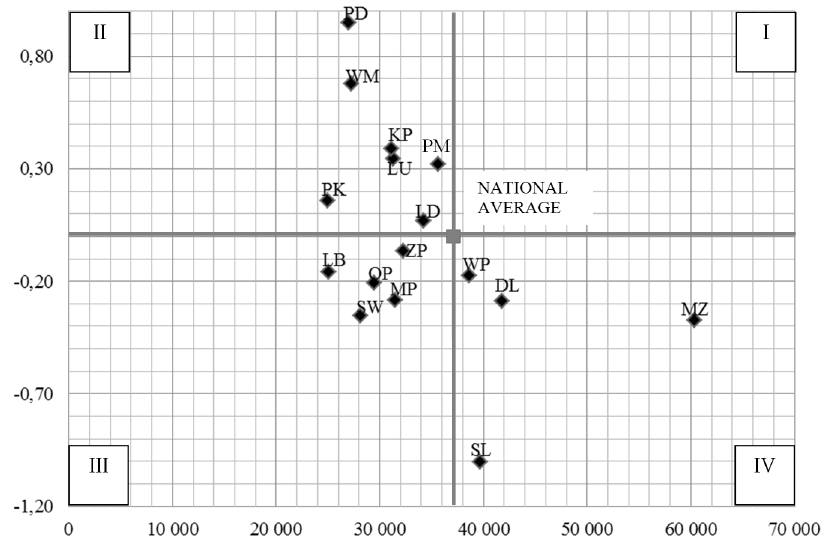
Figure 2. Gross Domestic Product in zloty per capita and the quality of the environment in Polish regions in 2010